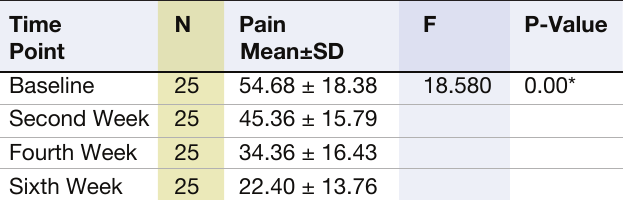
Sixth Week of Intervention